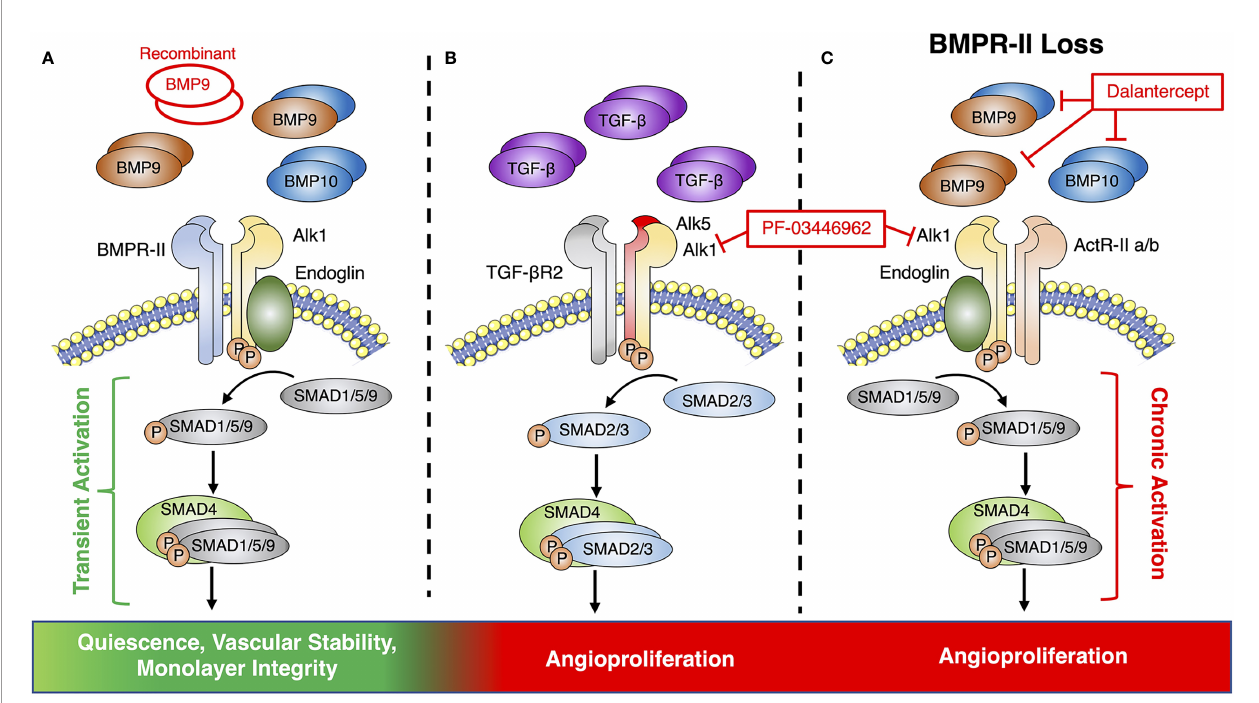
FIGURE 2 | Endothelial BMP9 and TGF b signaling via the Alk1 signaling axis. (A) Conventional endothelial BMP9 and BMP10 signaling via a receptor complex of Alk1 and BMPR-II leads to transient activation of downstream SMAD signaling, endothelial quiescence and vascular stability. Previous therapeutic studies have pursued vascular normalization by supplementing this pathway with recombinant BMP9. (B) Alk1 can also partner with ALK5 and TGF b R2 to form a receptor complex for TGF b to promote angiogenesis. (C) BMPR-II loss causes signaling via alternative type-II receptors, such as ActR-IIa/b, which can promote angiogenesis via the chronic activation of canonical SMAD signaling. Therapeutic targeting of pre-angiogenic signaling of TGF b or BMP9 via Alk1 has been pursued by receptor blockade with PF-03446962 or the Alk1-Fc ligand trap,